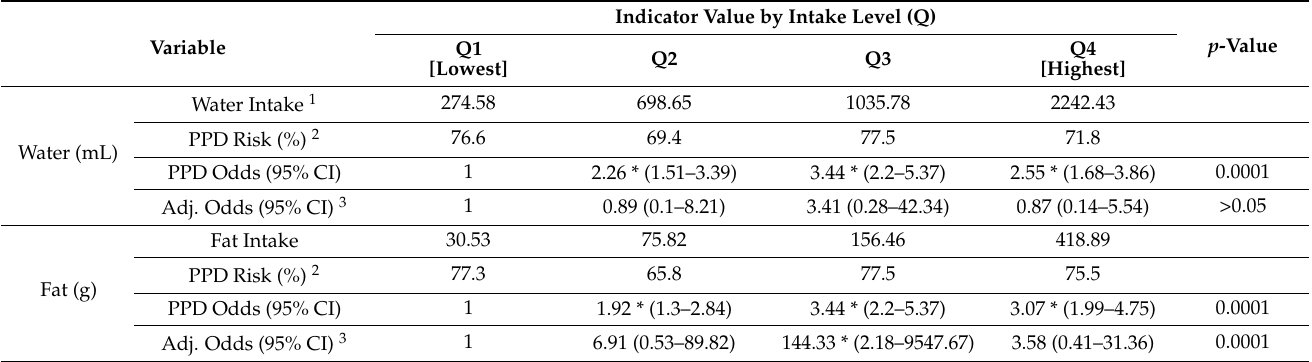
Table 3. The association between daily consumption of other nutrients and